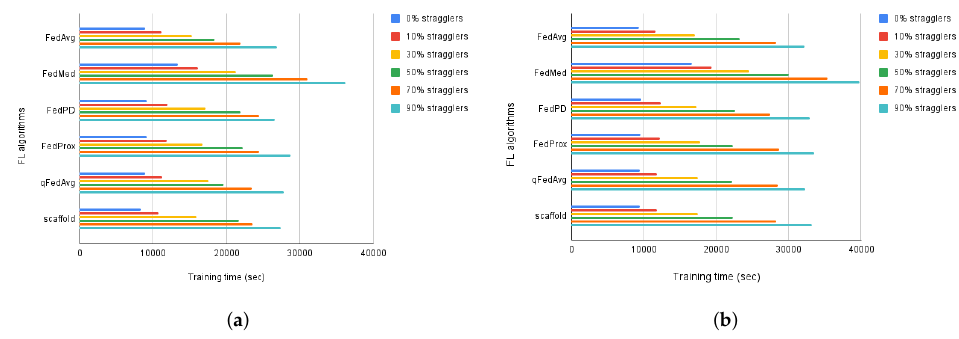
Figure 2. Training time of FL algorithms over ( a ) IID and ( b ) non-IID MNIST data for varying levels of stragglers.